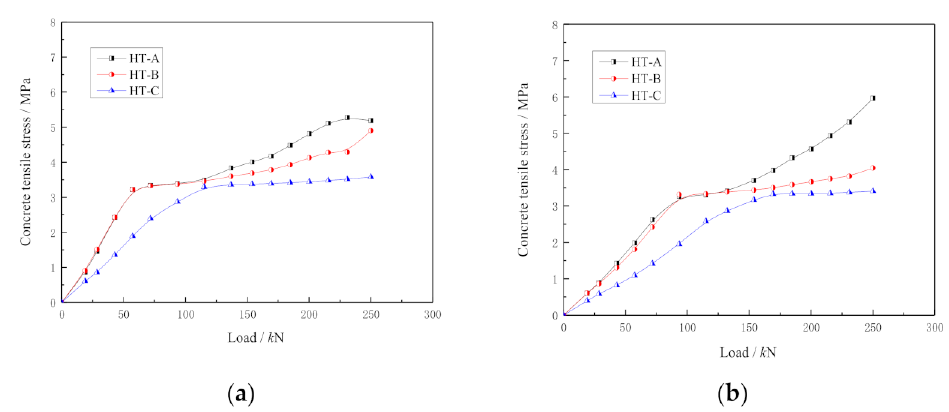
Figure 18. Concrete stress curve of GD-1 specimen: ( a ) No. 1 measuring point and ( b ) No.2 measuring point.